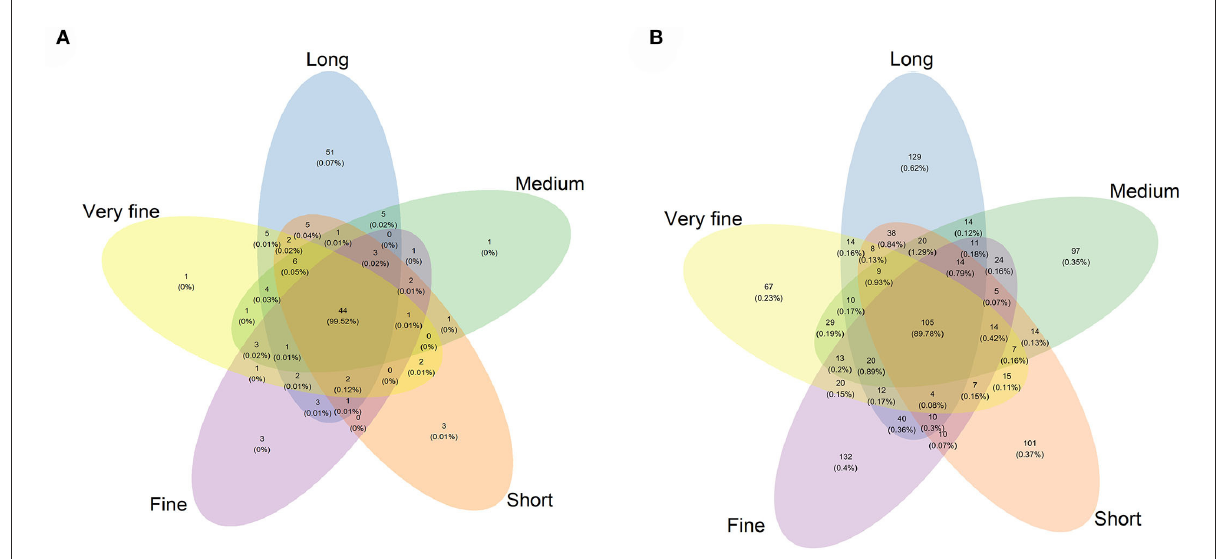
FIGURE1 Venn diagram of the OTUs among the five treatments of archaea (A) and fungi (B) . Long: 32.97% peNDF > 1.18 treatment; Medium: 29.93% peNDF >